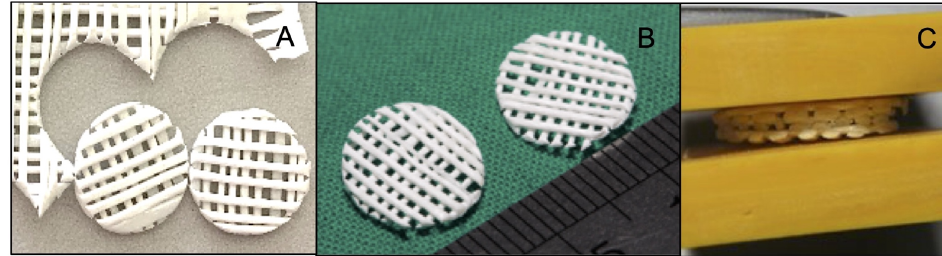
Figure 1. ( A ) and ( B ) The monolayer scaffolds were cut into circles. ( C ) The multilayer scaffold was made by stacking units of monolayer scaffold.